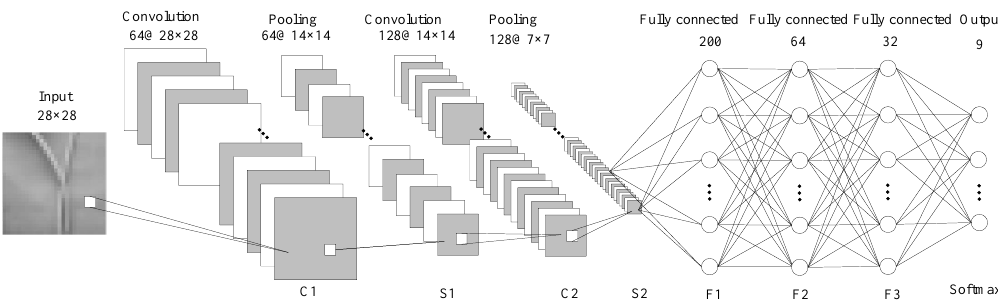
Figure 3. The structure of a convolutional neural network (CNN). Table 1. The configurations of the convolution, pooling, and fully connected (FC) layers.